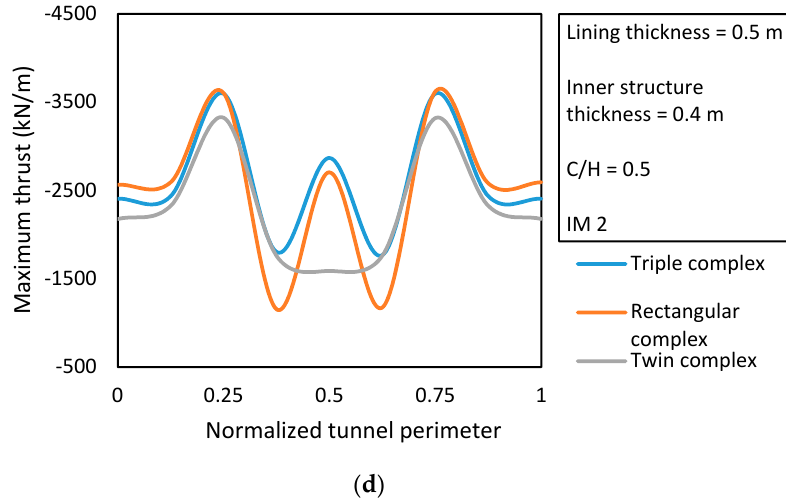
Figure 10. ( a – d ) Comparison among triple tunnel complex, equivalent twin tunnel complex, and rectangular tunnel complex in terms of: ( a ) surface displacements, ( b ) normalized tunnel perimeter, ( c ) maximum moments, and ( d ) maximum thrust generated along the perimeter.